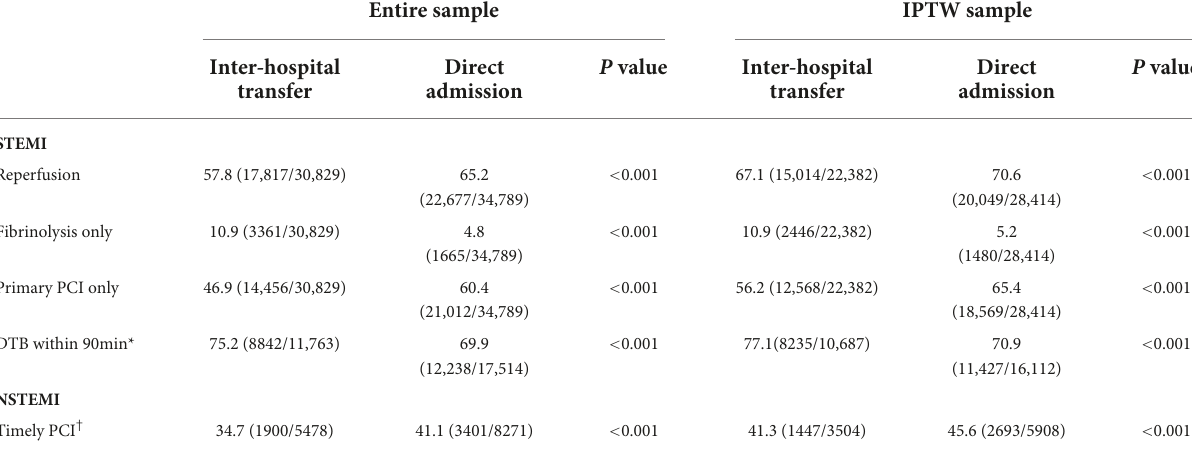
TABLE 2 Early revascularization of patients with AMI who were transferred from another hospital and directly admitted. Entire sample IPTW